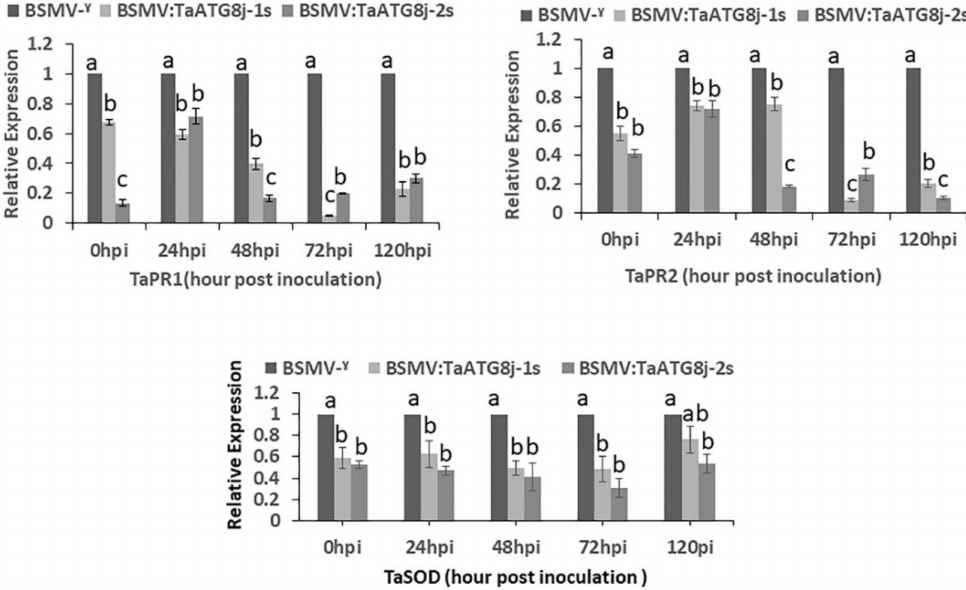
Figure 8. Transcription levels of defense-related genes in response to Puccinia striiformis f. sp. tritici in TaATG8j -silenced plants. The expression of TaPR1 , TaPR2 and TaSOD was quantified in TaATG8j -silenced plants comparedwith the control. The data were standardized to the wheat TaEF-1 α gene. Error bars indicate the variations among the three independent biological replicates. Different letters indicate significant differences ( p < 0.05) using the Tukey HSD